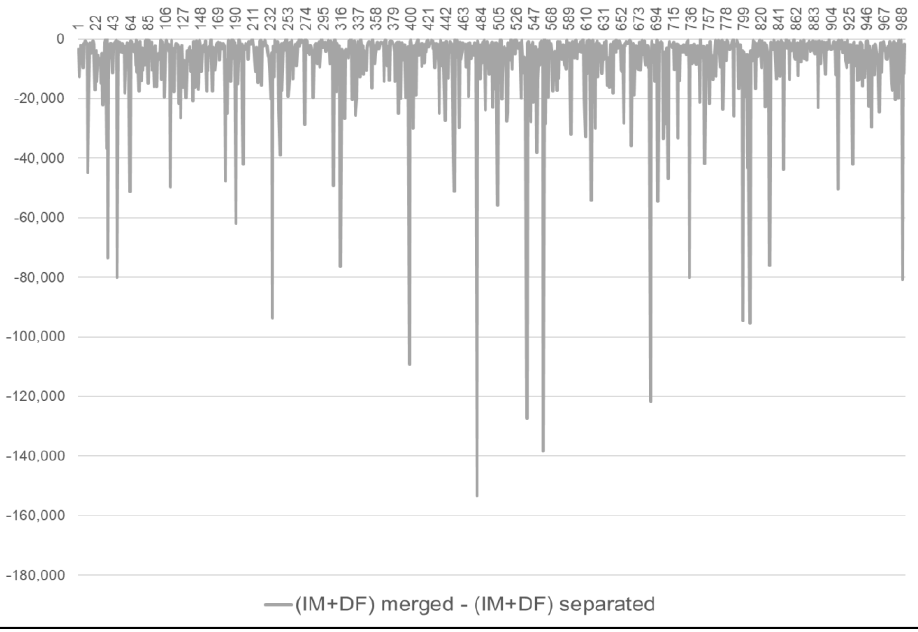
Figure 7. Difference between the guarantee values of the separated and merged markets.